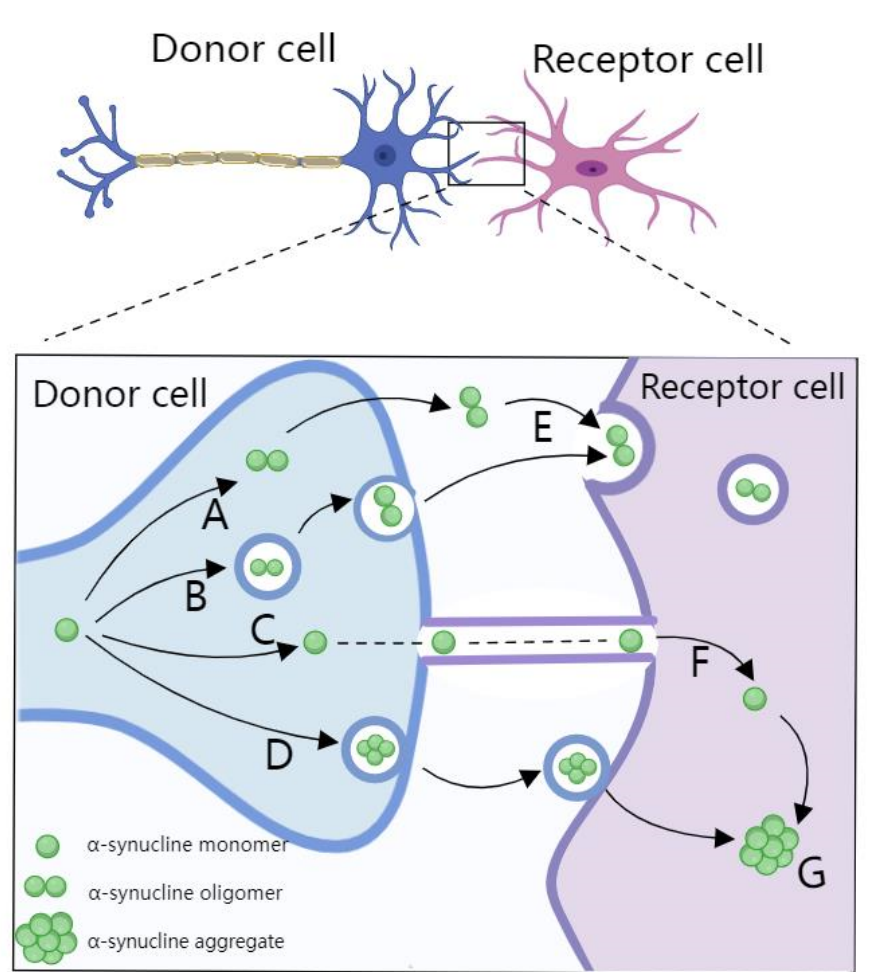
Figure 5. Proposed mechanisms of intercellular α‐ synuclein transmission. α‐ synuclein is transferred from donor cells into the extracellular space, as naked protein or in vesicles such as exosomes. They then act as seeds for protein aggregation in the recipient cells. Release mechanisms include the non‐vesicular release of free α‐ synuclein (A), exocytosis (B), transport via tunnelling nanotubules (C), and exosomal transport (D). Uptake mechanisms include endocytosis (E), exosome uptake (F), leading to α‐ synuclein aggregation formation (G).